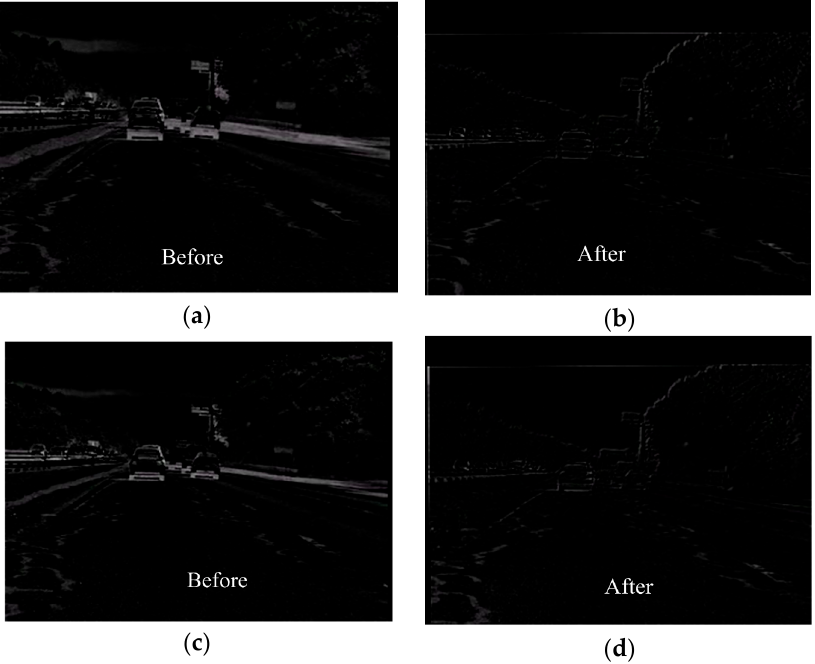
Figure 19. Frames in the original sequences ( a ) and stabilized sequences ( b ).